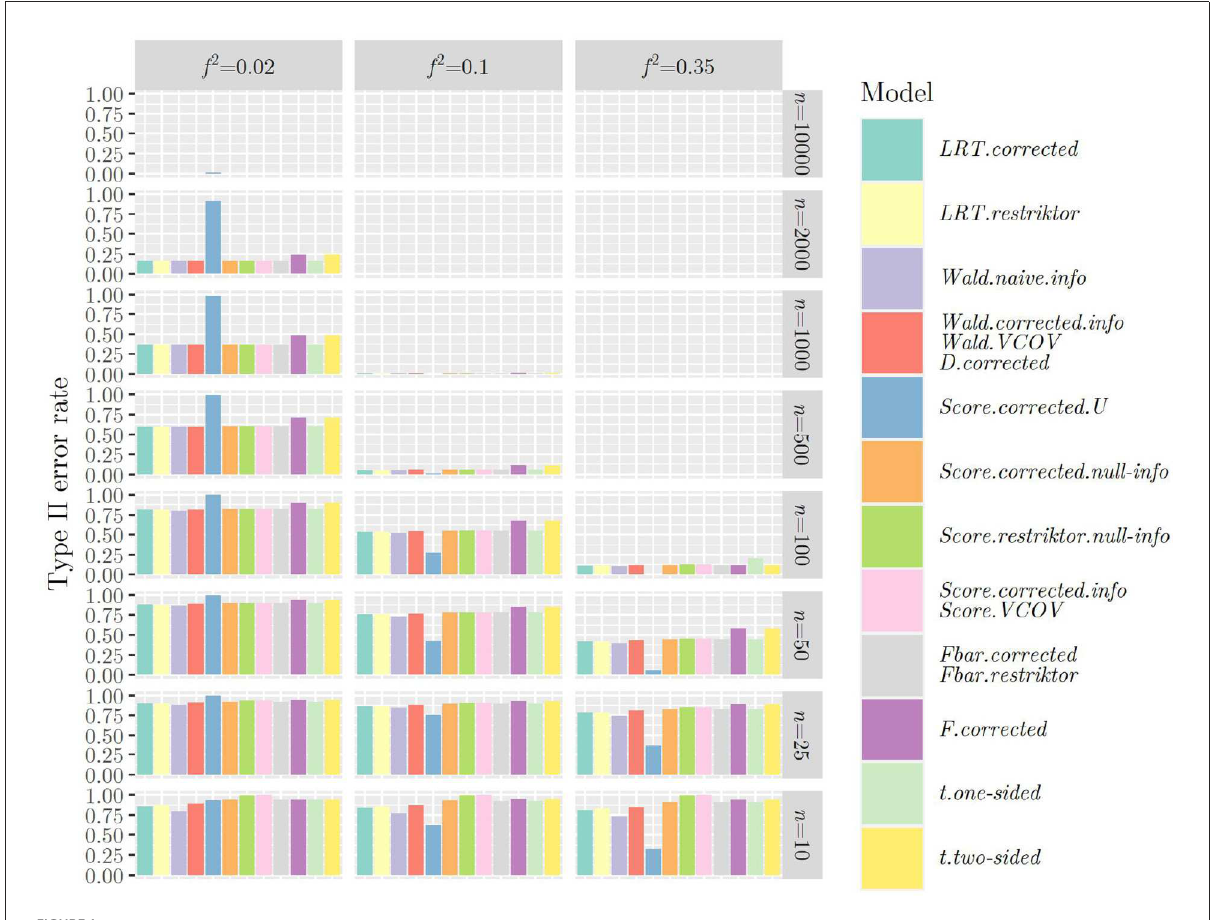
FIGURE1 Type II error rates when using R 1 and applying the test statistics as outlined in the referenced